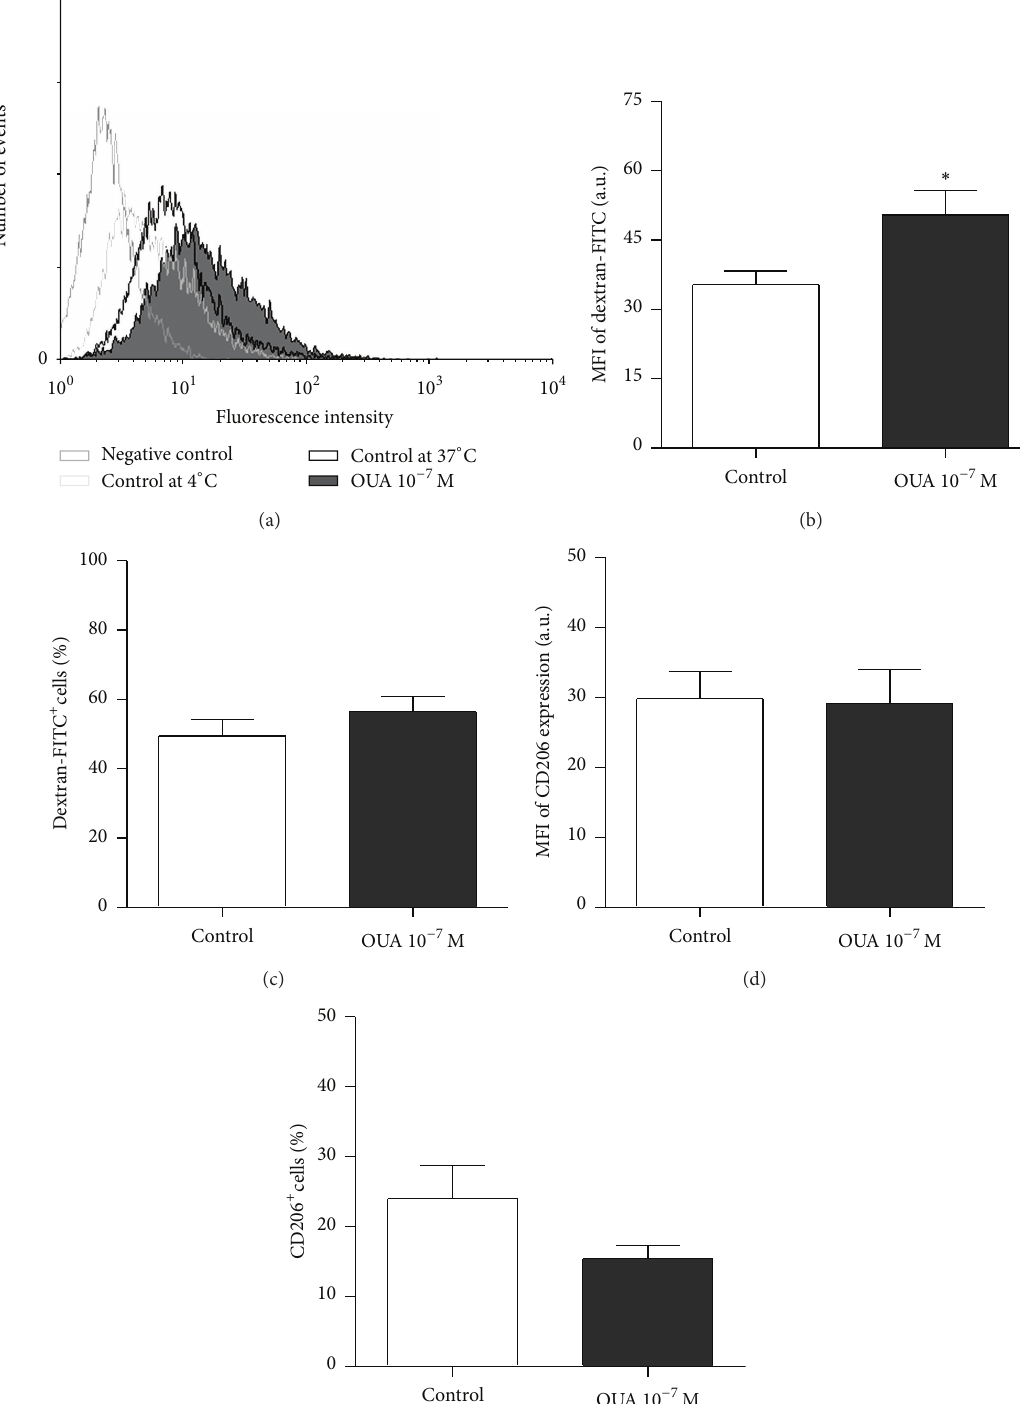
Figure 7: Effect of ouabain on dextran-FITC endocytosis and CD206 expression. Cells were cultured in the absence or presence of 10 −7 M of ouabain for 24 hours. After 24 hours, these cells were incubated for 1 hour with FITC-conjugated dextran (1mg/mL) for endocytic assays or incubated for 30 minutes with anti-CD206 PE-Cy5 to evaluate CD206 expression. Fluorescence signals were measured by flow cytometry. (a) Representative experiment showing the patterns of dextran uptake. Other results are expressed as (b) the mean of fluorescence intensity of dextran-FITC ± SEM and (c) the percentage of monocytes engaged in endocytosis—dextran-FITC + cells ± SEM. (d) The mean fluorescence intensity of CD206 ± SEM and (e) the percentage of CD206 + cells ± SEM. Data are representative of seven endocytic activity assays and four flow cytometric analysis of CD206 expression. ∗ 𝑃 < 0.05 using two-tailed paired t